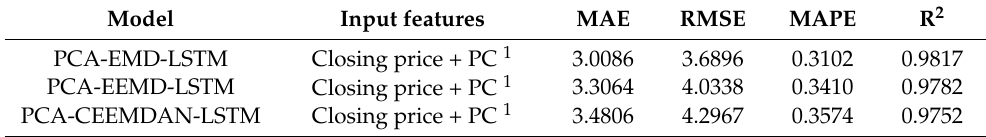
Table 10. Results of the prediction models with different advanced versions of EMD.